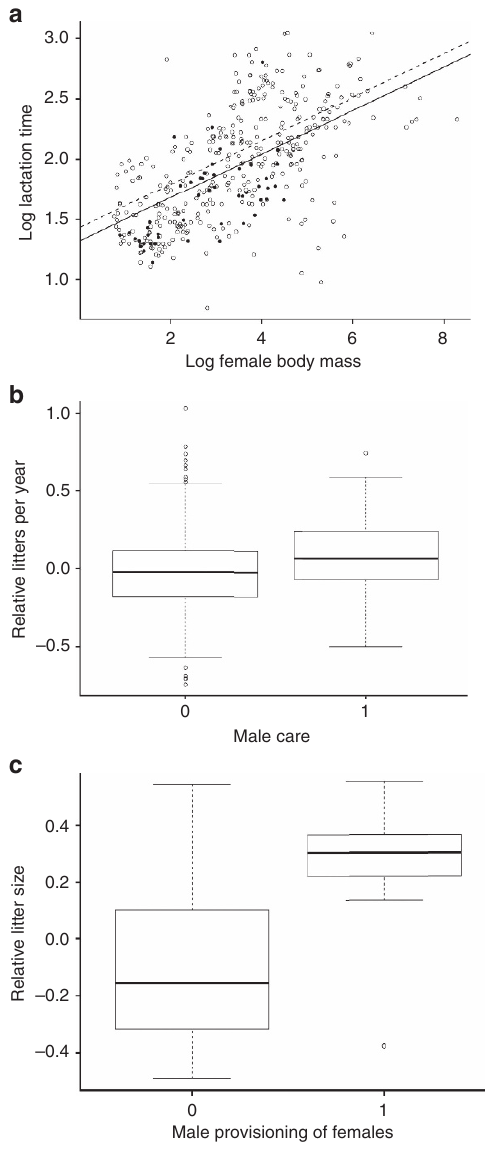
Figure 2 | Male care and female life history traits across all mammals. ( a ) For a given female mass, lactation time is shorter in species with male care (filled circles) than species without it (open circles) (PGLS in Table 1: n ¼ 390). Best fitting line for species with male care in solid black, dashed line for species without male care. ( b ) The relative number of litters per year, after accounting for gestation time, lactation time and female mass, is higher in species with male care (coded as 1) than species without (coded as 0) (PGLS in Table 1: n ¼ 370). ( c ) Relative litter size, after accounting for female body mass, is larger in species where males provision reproducing females (coded as 1) than species without (coded as 0) (PGLS in Table 1: n ¼ 448). Figures in ( b , c ) report the median with upper and lower quartiles (boxes) and 95% confidence intervals (whiskers) of the residuals of litters per year ( b ) and litter size ( c ) computed from the reduced models in Table 1. All continuous data are log 10 (Supplementary Table 10). Litter size is unrelated to male care in primates, while provisioning reproducing females is associated with larger litters in carnivores (Table 2; Supplementary Table 11). Litter size is larger in socially monogamous rodents but unrelated to male care behaviours in this order (Supplementary Table 11). Mass at birth and mass gain from